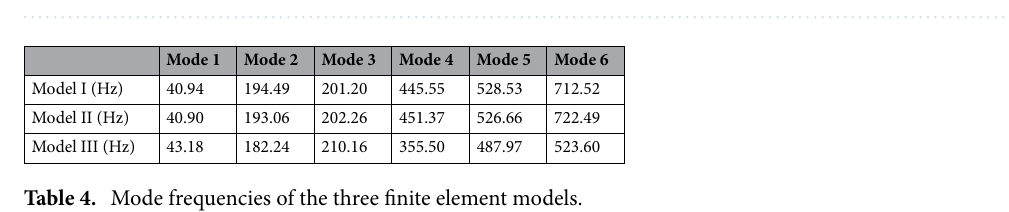
Figure 5. The modal deformation analysis results for ( a – f ) Model I, ( g – l ) Model II and ( m – r ) Model III. ( a , g , m ) Mode 1 is the up-down flapping mode; ( b , h , n ) Mode 2 is a bending and twisting mode; ( c , i , o ) Mode 3 is the front-back flapping mode; ( d , j , p ) Mode 4 is a twisting and bending mode; ( e , k , q ) Mode 5 is the twisting mode; ( f , l , r ) Mode 6 is a twisting and bending mode.